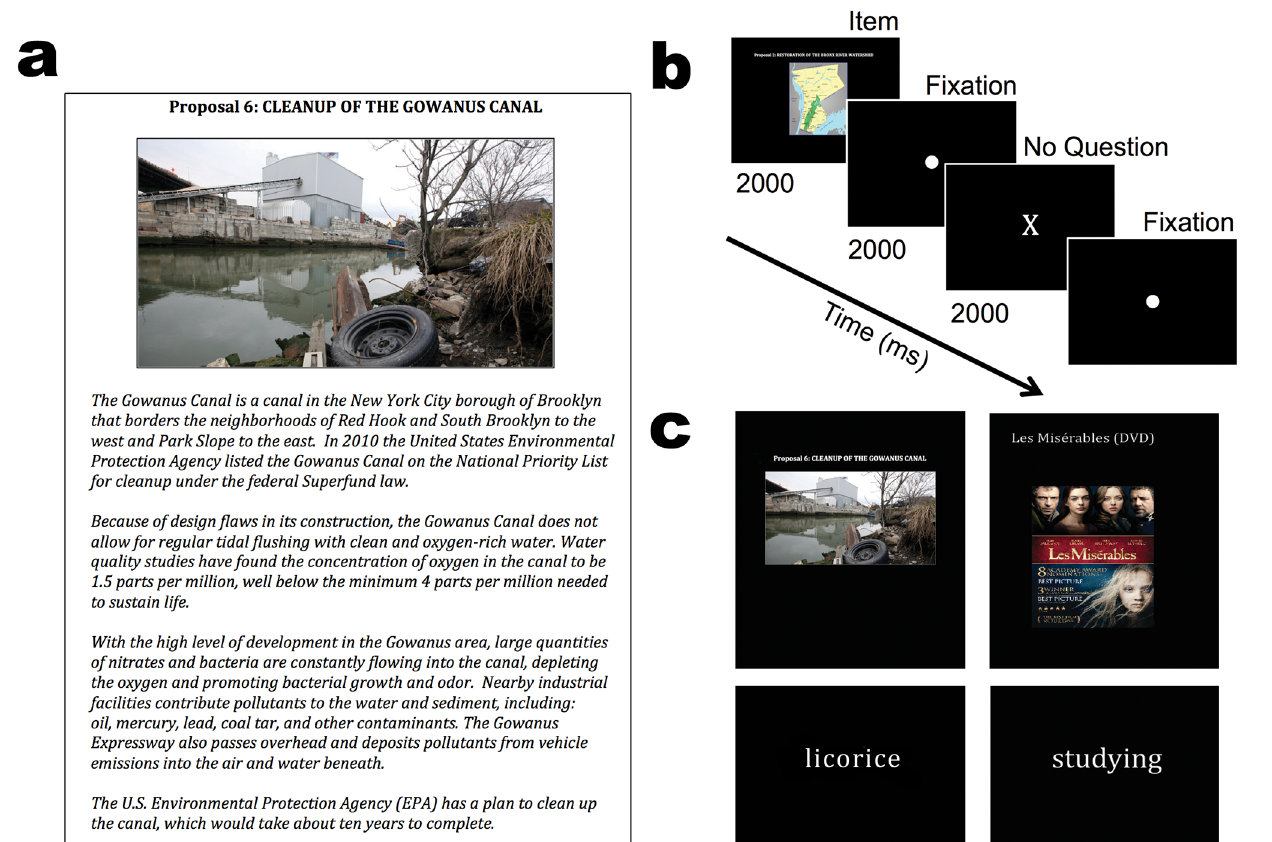
Fig 1. (a) Sample page from 1 (out of 6) environmental proposals that were designed for the experiment. (b) Timeline of a trial inside the scanner, whereby subjects witnessed each good for 2 s, followed by a fixation point for 2 s. Subjects then either saw a question trial for alertness or a cross lasting for 2 s.